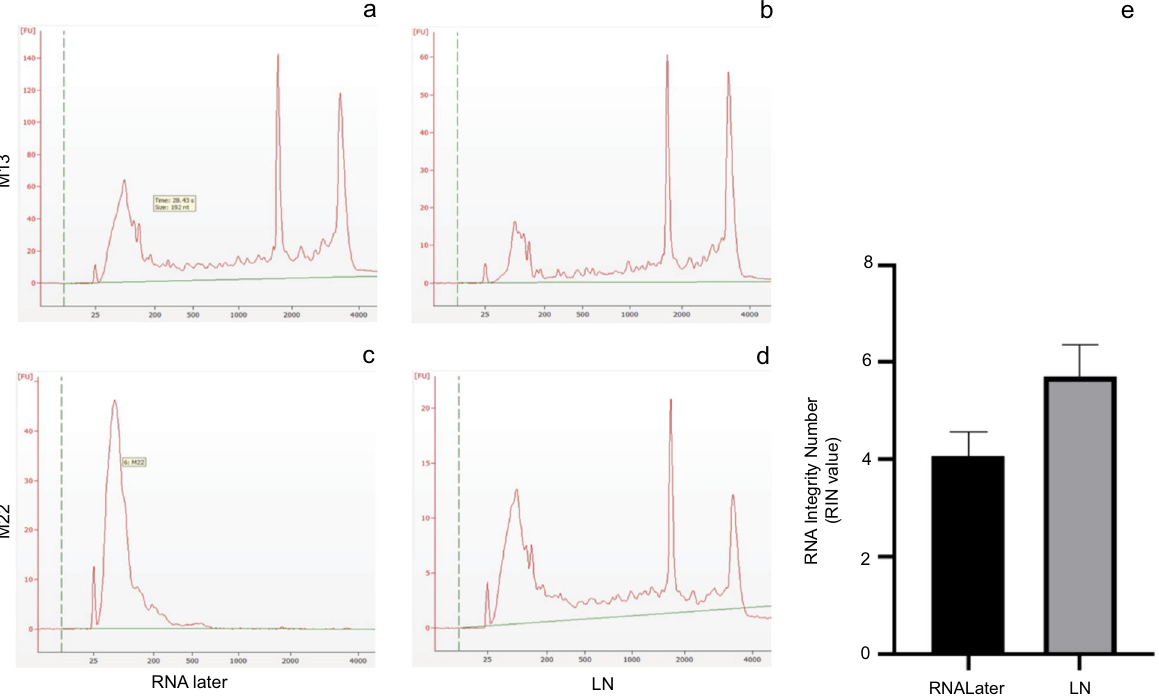
Fig. 2 RNA quality of liquid nitrogen snap-frozen and RNAlater preserved ovarian tissues. Representative electropherograms from 2 animals (M13 vivarium control a , b and M22 fl ight c , d ) perserved in RNAlater ( a , c ) or LN ( b , d ). e Histogram of RIN values from analysis of paired LN and RNALater samples ( n = 12; 4BL, 4VC, 2HC, 2FL). *Means ± SEM RIN values were signi fi cantly ( p ≤ 0.05) different based on the preservation method.